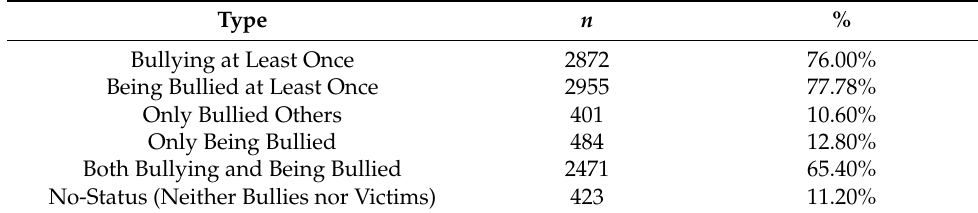
Table 1. Basic statistics for bullying and victimization ( n = 3799).